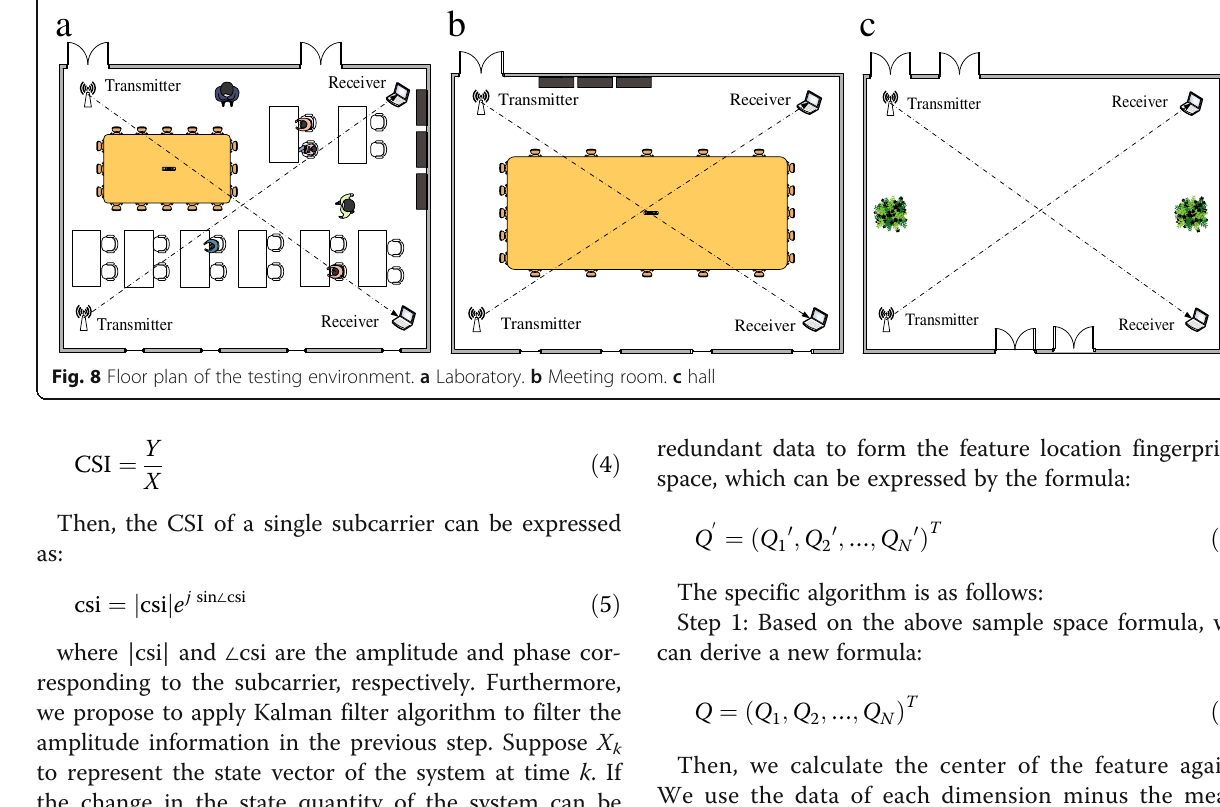
Table 1 The accuracy of each methods under different situations Different method in different scenarios